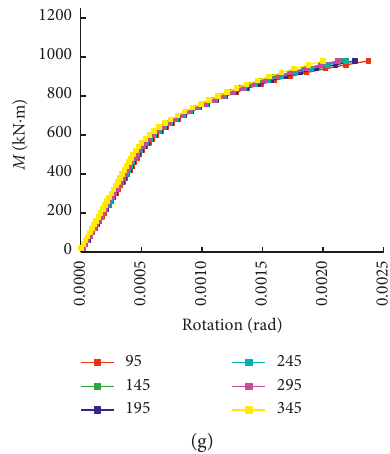
Figure 19: Bending moment-rotation curves for different tenon lengths under axial loads of (a) 500 kN, (b) 1000kN, (c) 1500kN, (d) 2000kN, (e) 2500kN, (f) 3000kN, and (g)